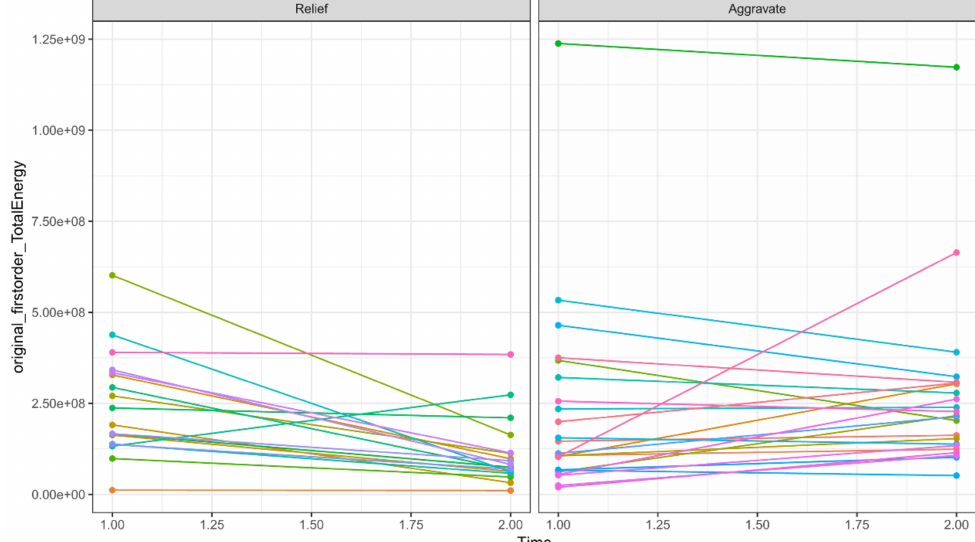
Figure 7. The differences of original_firstorder_TotalEnergy between relief and aggravate